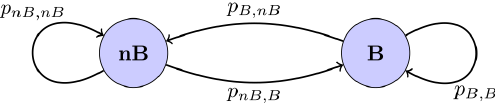
Figure 4. A general example of a network diagram of a homo- geneous Markov chain with two states: nB (no blocking) and B (blocking). Arrows indicate transitions and p ij the associated transition probabilities between state i and j with, i,j ∈ { nB ,B } . After Baclawski